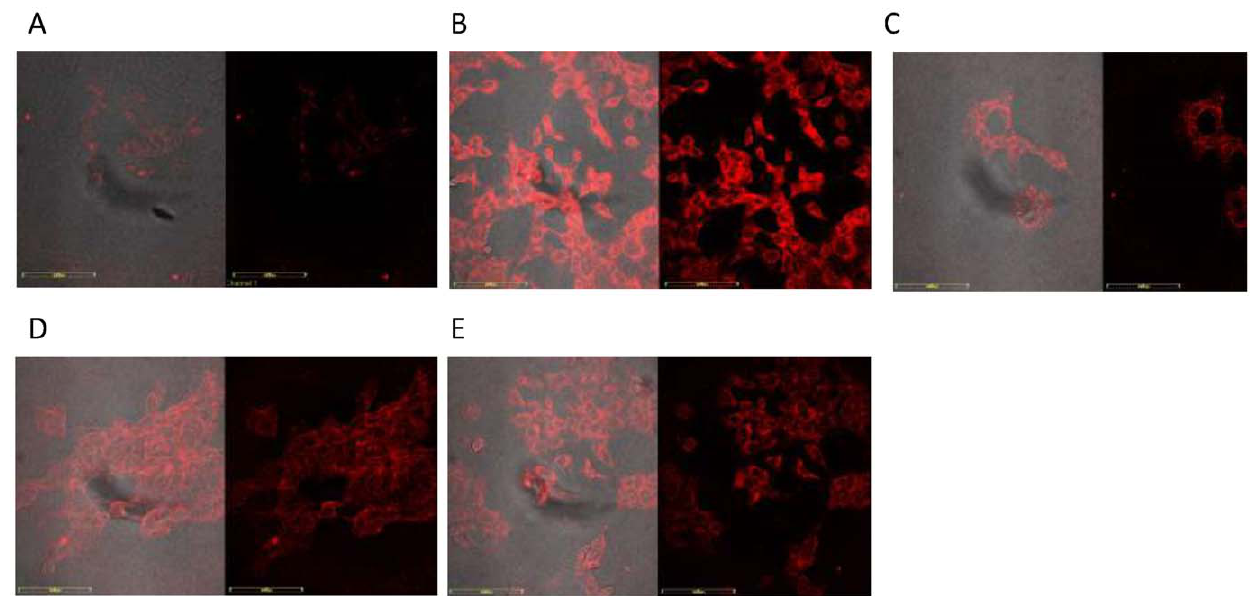
Figure 6. Confocal images of aptamers staining with cultured DLD-1 cells. Cells were incubated with aptamer conjugated with biotin and the binding event was observed with PE-conjugated streptavidin. A (unselected library showing the background binding); B (KDED2); C (KDED3); D (KDED5) and E (KDED7).